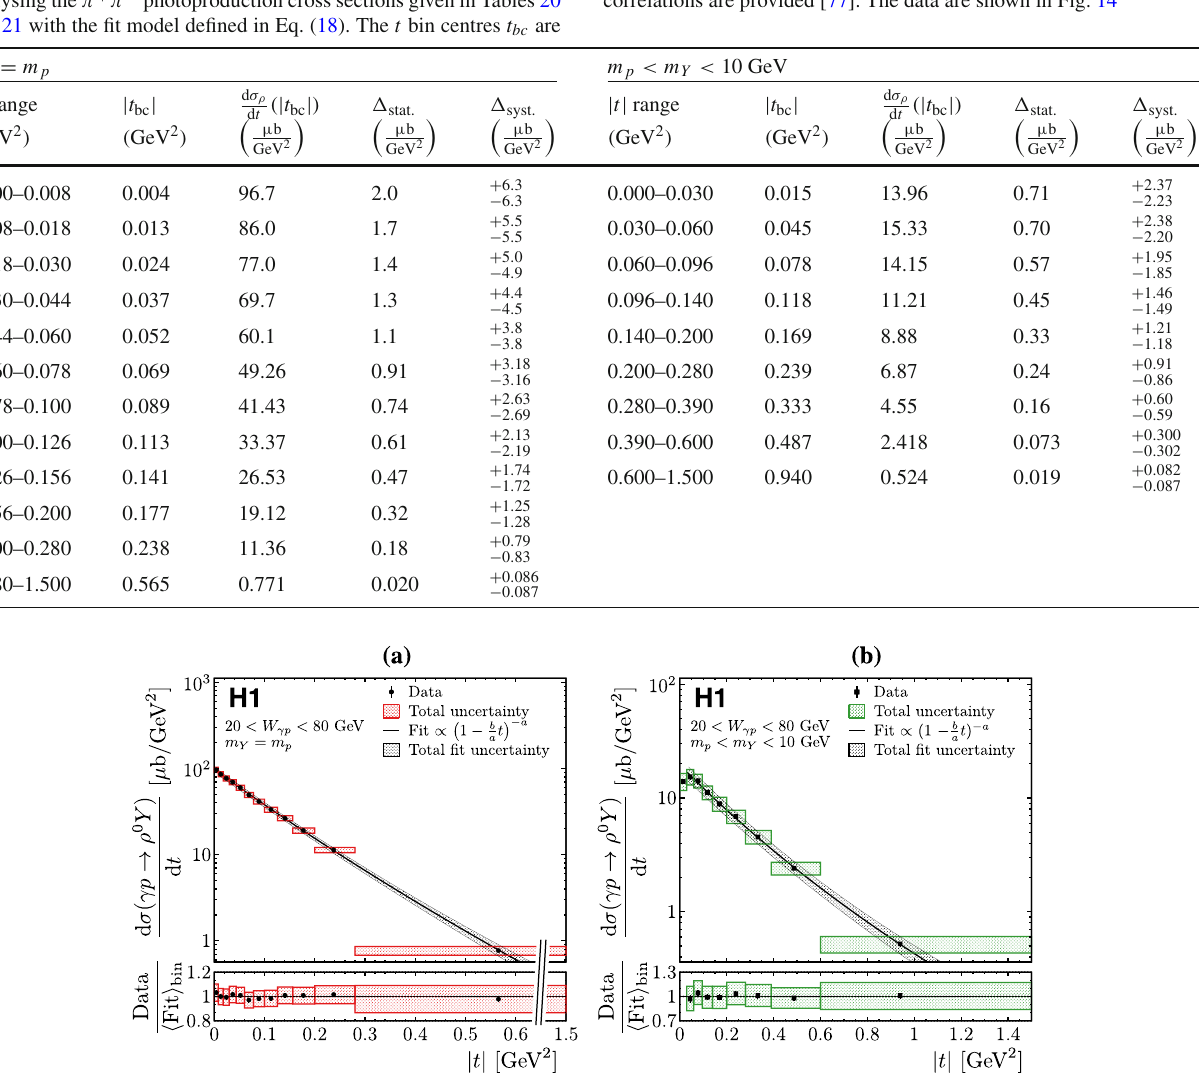
calculated as described in the text. The statistical and full systematic uncertainties including normalisation uncertainties are given by (cid:20) stat. and (cid:20) syst. , respectively. A full uncertainty breakdown and statistical correlations are provided [77]. The data are shown in Fig. 14